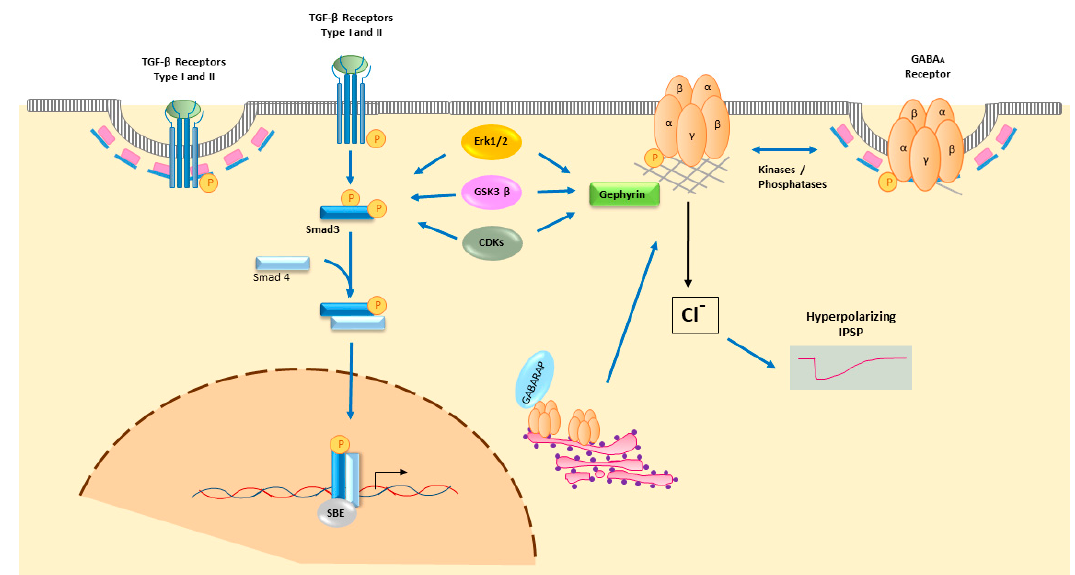
Figure 1. Summary illustration of TGF- β signaling and postsynaptic GABAR